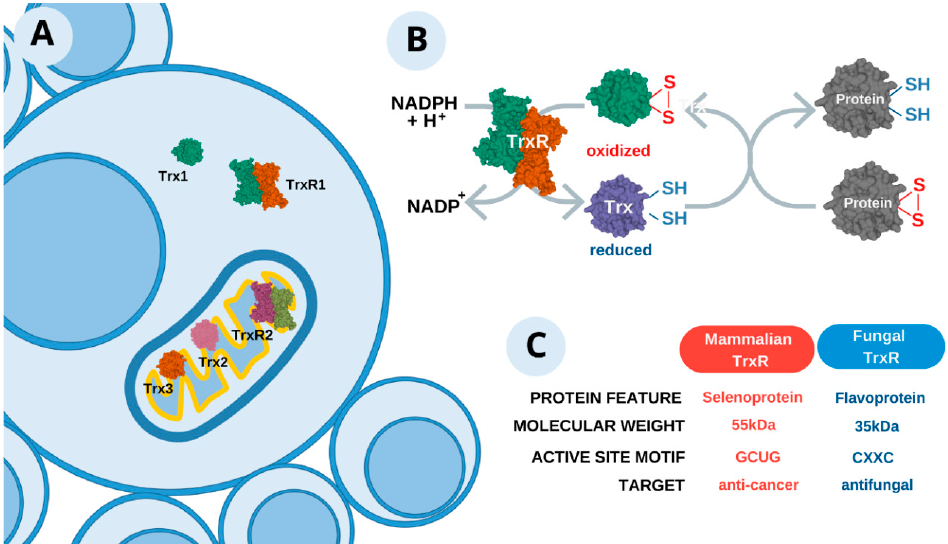
Figure 2. Thioredoxin system, an important means to control oxidative stress. ( A ) Cyto-localization of the thioredoxin system in Paracoccidioides sp. Three isoforms of thioredoxin were identified, namely Trx1 (cytoplasmatic) and Trx2 and Trx3 (mitochondrial). Thioredoxin reductase (TrxR) also participates in this system, which presents two forms, one in each compartment. ( B ) Schematic representation of the mechanism of action. The oxi-reduction reaction occurs so that cellular proteins are constantly available to control situations of the reactive species inside the fungus. ( C ) Comparison from thioredoxin systems between human and fungi.